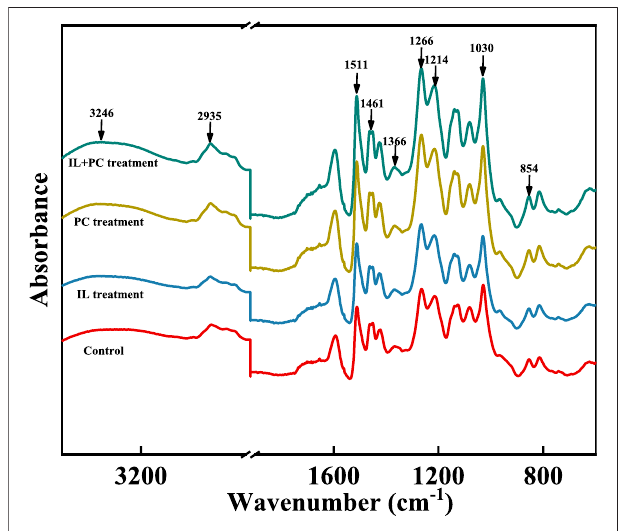
FIGURE 3 | FTIR spectra of alkali lignin samples before and after fungi